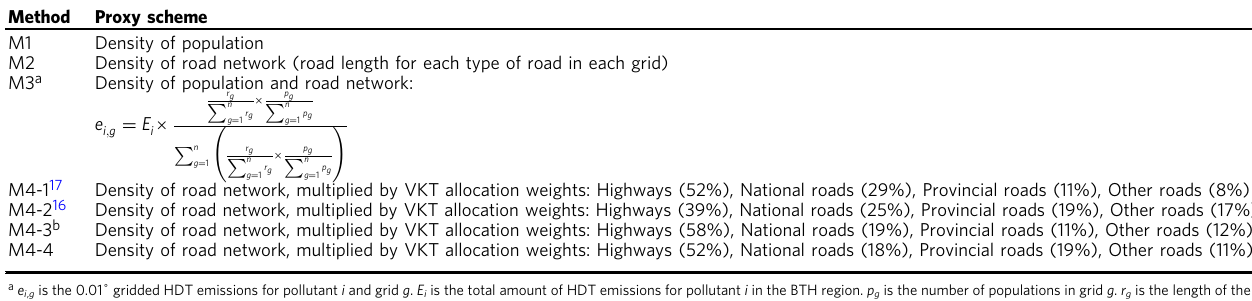
Table 2 Descriptions of the seven HDT emissions allocation methods.